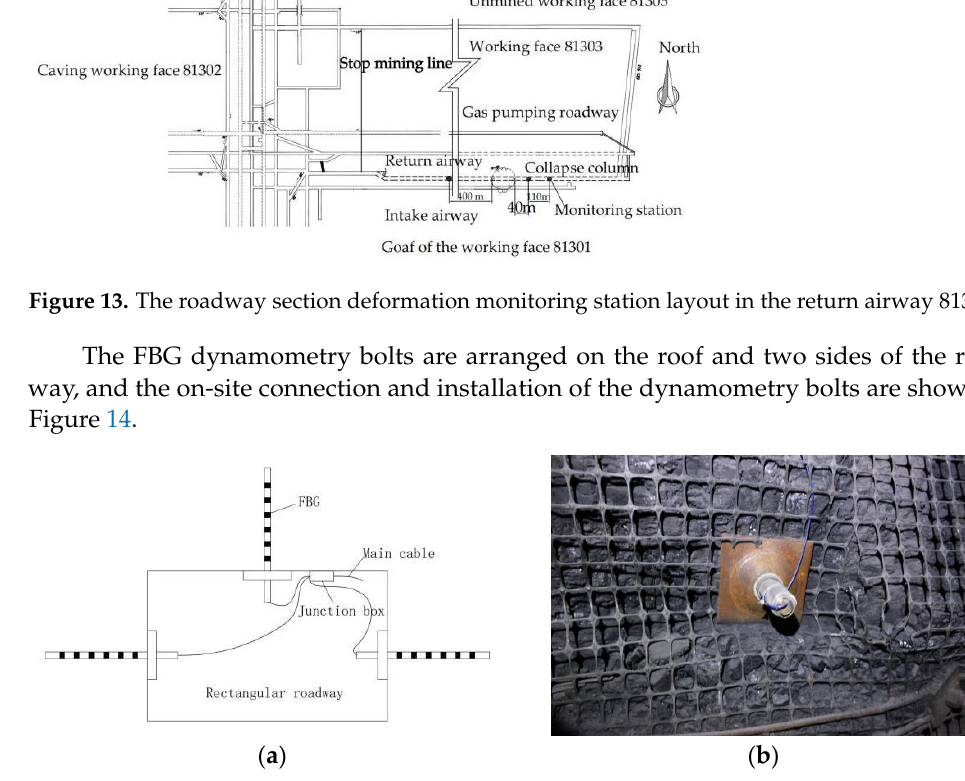
Figure 15. The stress of the bolt in different positions from the head of the tunnel face. ( a ) The roof bolts on the roadway, ( b ) the bolts on the solid coal side, and ( c ) the bolts on the narrow coal pillar side. From Figure 15, it can be analyzed that the roadway is in the excavation influence period, from 5–20 m away from the head, the tensile force of the roof bolts and the 2 sets of bolts are small, and the force distribution of the bolt body is relatively uniform. The stress of the roof bolt reaches the maximum at 70 m from the head and the maximum stress of the bolt occurs at 800 mm from the periphery of the roadway. The stress of the bolt for the solid coal side reaches the maximum at 90 m from the head, and the maximum stress occurs at about 500 mm from the surrounding of the roadway. The stress of the bolt for the narrow coal pillar side reaches the maximum at 90 m from the head, and the max- imum stress occurs at about 1000 mm from the periphery of the roadway. 6. Conclusions In this paper, it is assumed that the adhesive layer is a linear viscoelastic material and its creep mechanical behavior is expressed by the standard linear solid model. The shear